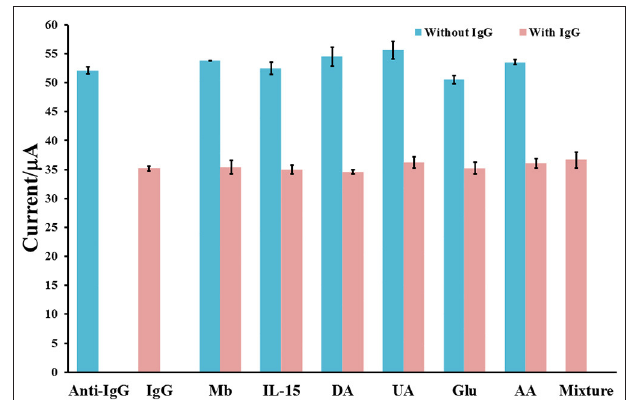
FIGURE 7 | Interference study for label-free immunosensing of human IgG using Cu(II)/GO-modified SPCE.